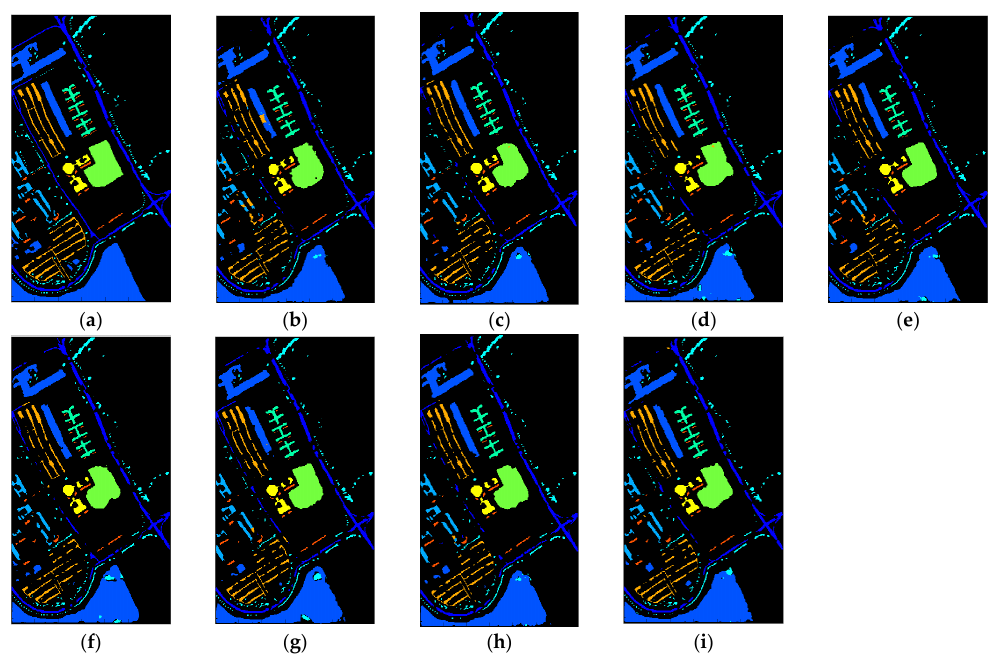
Figure 6. Classification maps produced by ILCMV for Pavia using bands selected in Table 2. ( a ) Ground truth, ( b ) Full bands, ( c ) UBS, ( d ) MEAC, ( e ) MDPP, ( f ) DSEBS, ( g ) SQ LCMV-BSS-1, ( h ) SQ LCMV-BSS-2, ( i ) SC LCMV-BSS.